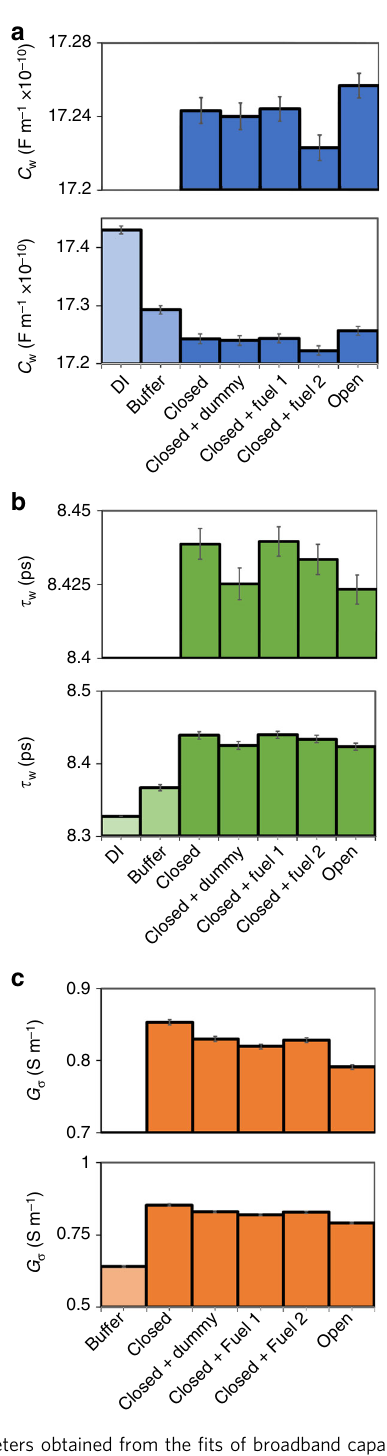
Fig. 6 Parameters obtained from the fi ts of broadband capacitance and conductance for tweezer suspensions. a Dipolar contribution of water C w . b Relaxation time of cooperative water relaxation τ w . c Bulk fl uid conductance G σ . Error bars represent a 95% con fi dence interval on the values (top plots provide an enlarged view of the differences between tweezer samples). Closed + loop and Closed + locker correspond to the additions of FUEL 1 and FUEL 2,